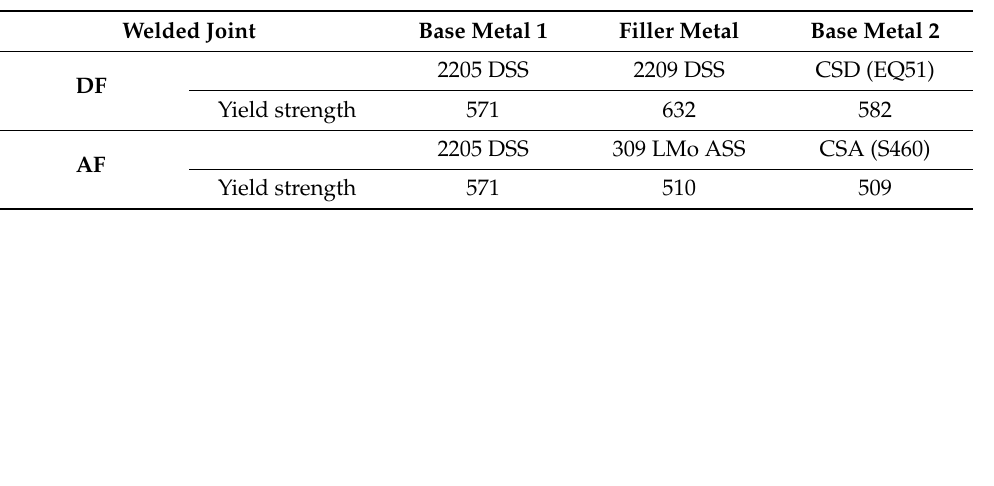
Table 1. Yield strengths (MPa) of the materials used for dissimilar-metal